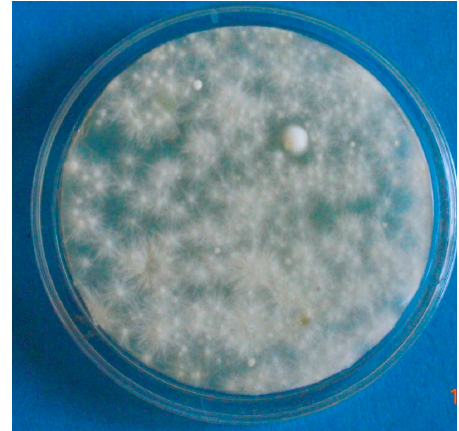
Figure 4. Environmental sample (contact plate from sofa, case # 1). Widespread growth of colonies of M. canis.